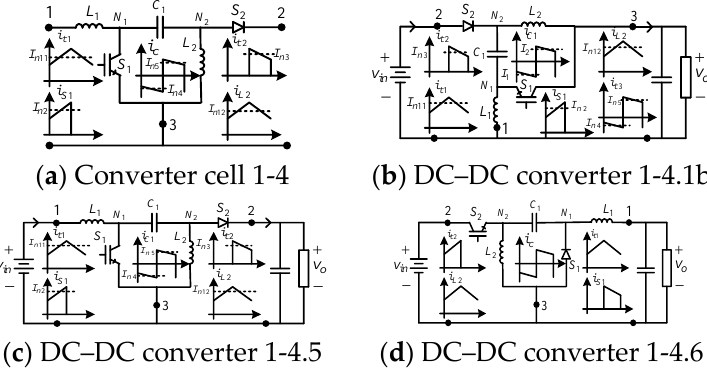
Figure 7. Converter cell 1-4 and three DC – DC converters derived from it .